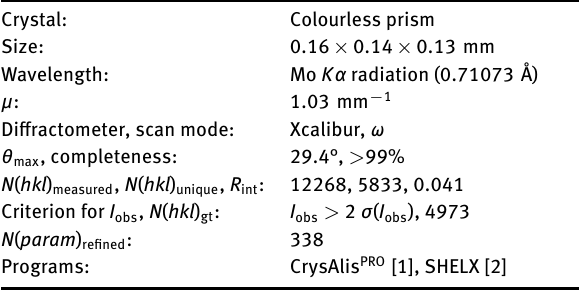
Table 1: Data collection and